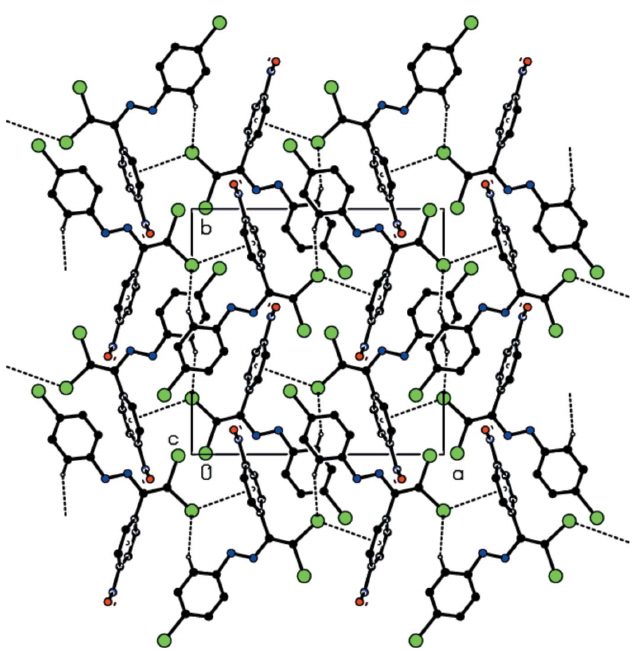
Figure 4 View down the c axis of the title compound, showing the C—Br (cid:2)(cid:2)(cid:2) (cid:2)